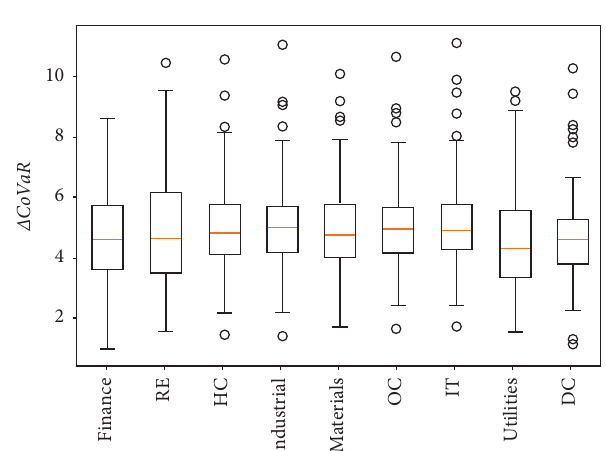
Figure 5: Histogram of ∆ CoCVaR .